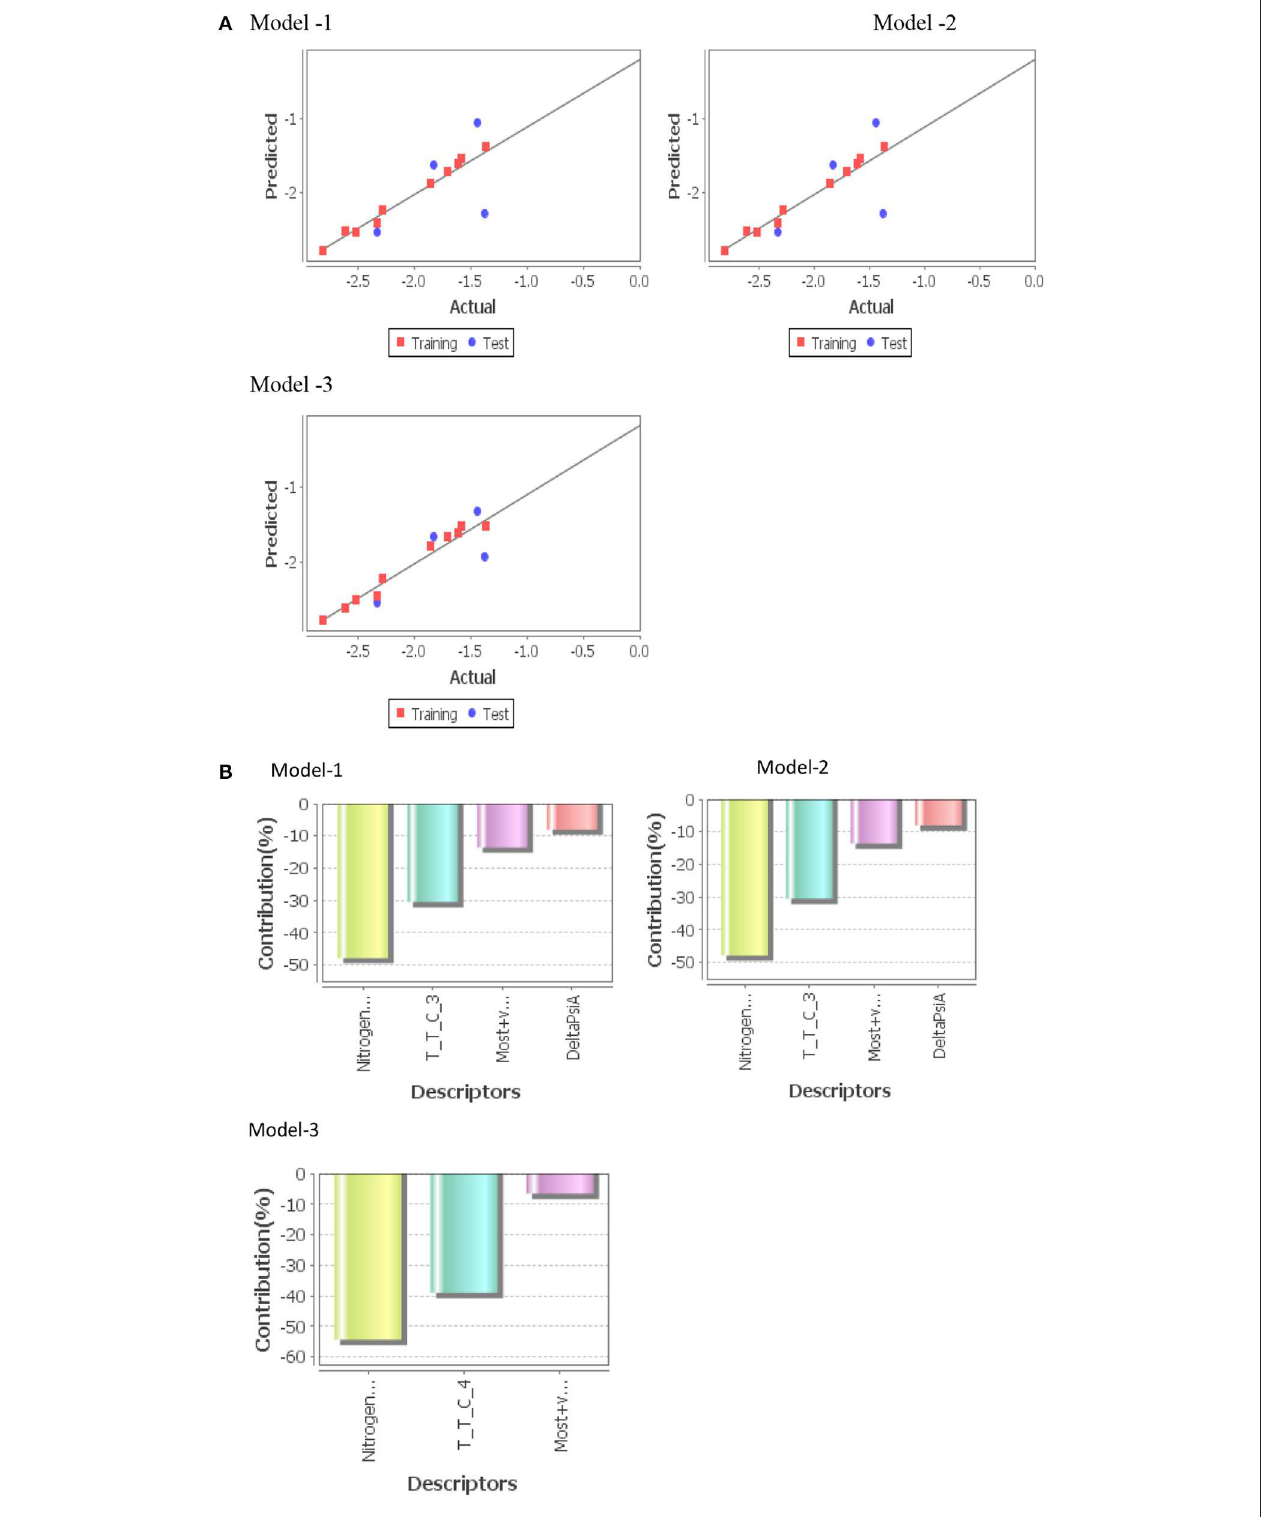
FIGURE 4 | (A) Graphs of experimental vs. predicted fungicidal activity of different models against S. rolfsii. (B) Contribution charts of 2D-QSAR model.